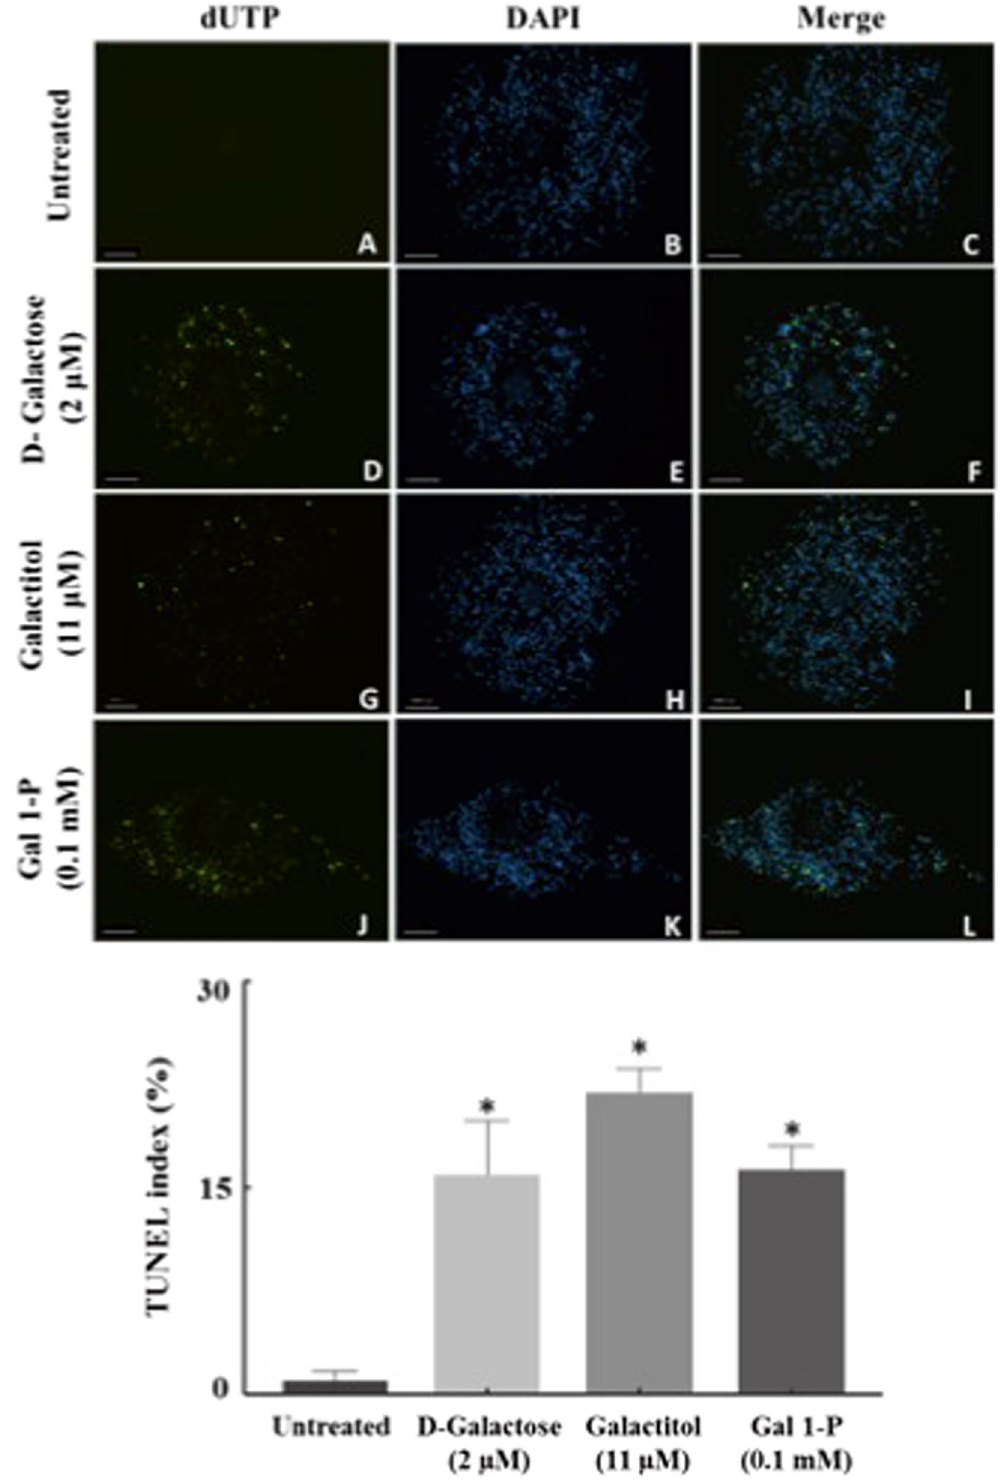
Figure 7. Detection of apoptosis by TUNEL in the cumulus-oocyte complex. Images ( A – L ) represent images of TUNEL assay (dUTP) (green), DAPI fluorescence (blue) and merged images of dUTP and DAPI in oocyte cumulus complex exposed to galactose (Images D – F ), galactitol (Images G – I ), and galactose 1-phosphate (Images J – L ), compared to untreated control (Images A – C ). Scale bars: 100 μ m. Images shown are from a typical experiment performed at least three times. The number of TUNEL-positive cumulus cells were increased by D-galactose, galactitol and galactose 1-phosphate compared to no-treatment control. TUNEL Index was determined as the ratio of TUNEL-positive cells to total counted cell nuclei and presented as mean ± SEM (standard error of mean). * p < 0.05 compared to